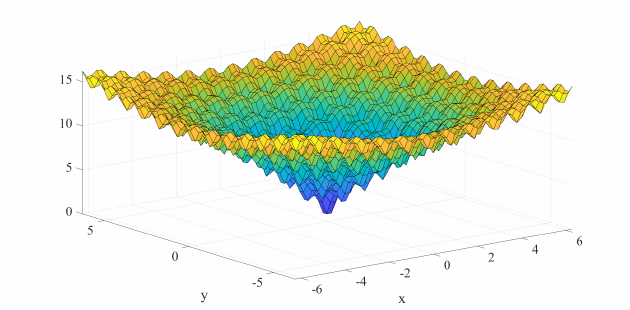
Figure 7. 3D plot of f 1 (Ackley’s function).